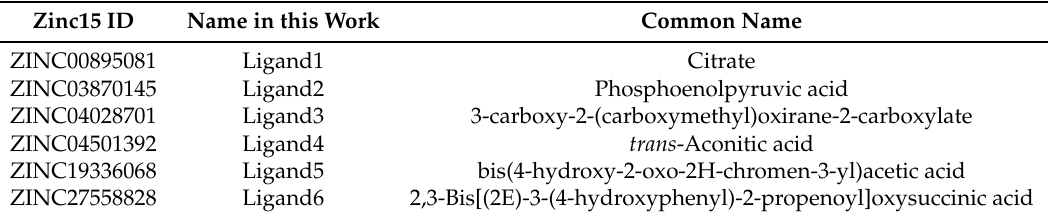
Table 1. ZINC15 ID and common name for best six MM/PBSA binding free energy score